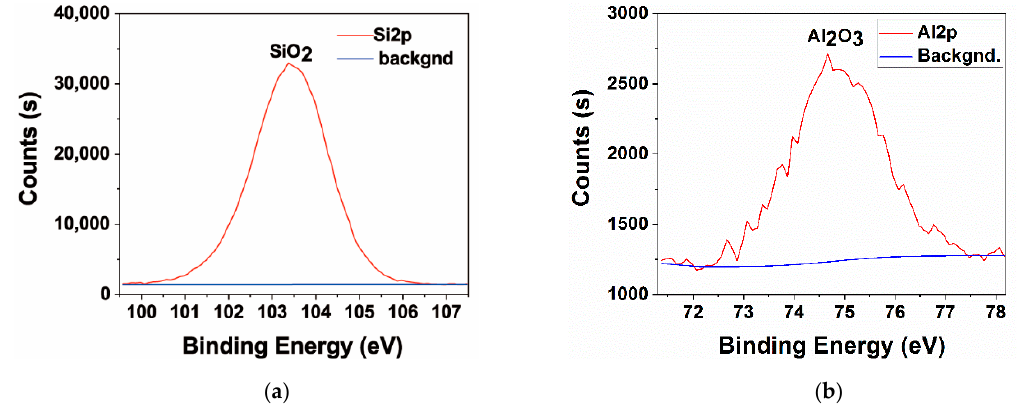
Figure 10. XPS spectrum of ( a ) the Si and ( b ) Al of T ‐ 1 sample.